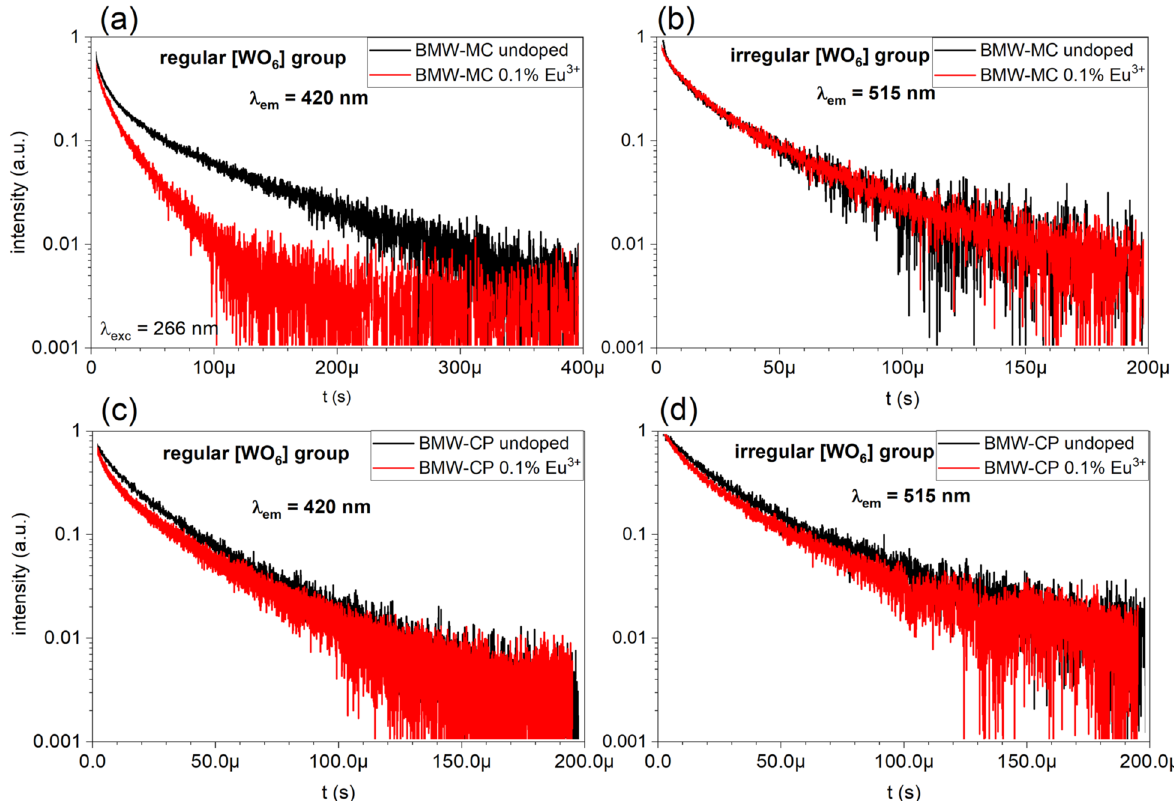
Figure 5. 77 K luminescence decay curves of tungstate groups in doped and undoped BMW samples: MC— regular WO 6 ( a ), MC—irregular WO 6 ( b ), CP—regular WO 6 ( c ), CP—irregular WO 6 ( d ) The emission was monitored at 420 and 515 nm, for the regular and irregular WO 6 group,